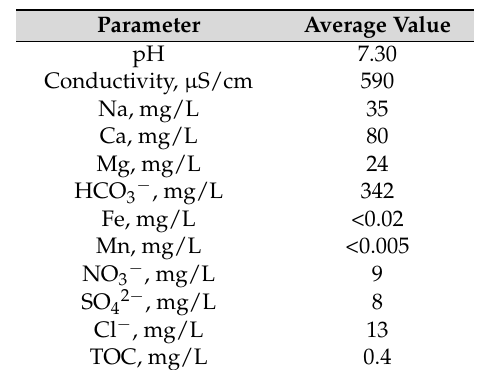
Table 1. Major physicochemical characteristics of Thessaloniki tap